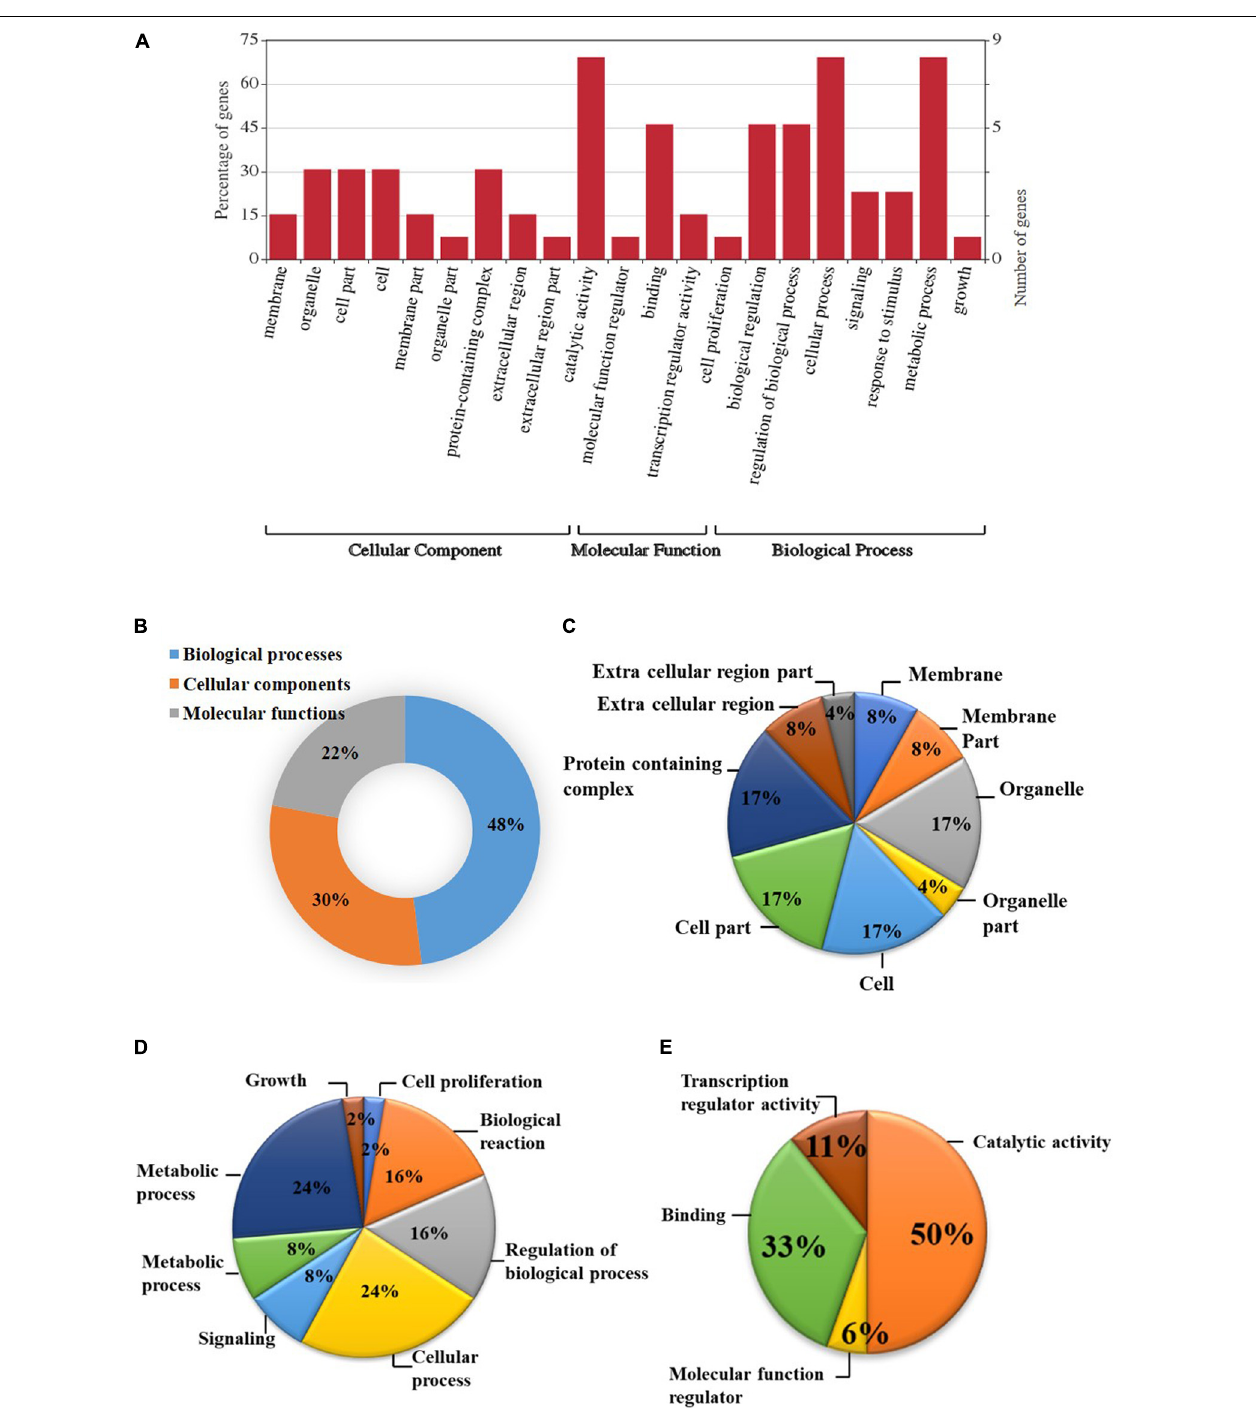
FIGURE 2 | Gene ontology (GO) enrichment analysis of differentially expressed genes (DEGs). (A) DEGs were characterized under the cellular components, molecular functions, and biological processes based on GO analysis; (B) Pie chart describing the Gene Ontology (GO) analysis of differentially expressed genes (DEGs) and their distribution under different GO terms. DEGs were categorized majorly under biological processes (48%) followed by cellular components (30%), and molecular functions (22%); (C) A major category of DEGs fall under cellular processes in which most of the DEGs belongs to cell, cell part, organelle, and protein-containing complex (17%) followed by membrane, membrane part, and extracellular region (8%); (D) In biological processes, cellular and metabolic processes (24%), regulation of biological process, and biological reaction (16%), etc. were enriched; (E) DEGS categorized under molecular functions were mainly distributed under catalytic activity (50%), binding (33%), transcription regulator activity (11%), and molecular function regulator (6%).